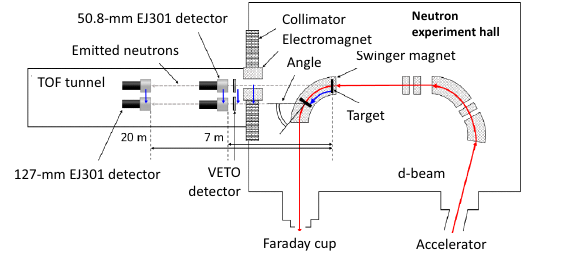
Figure 1. Layout of the experimental